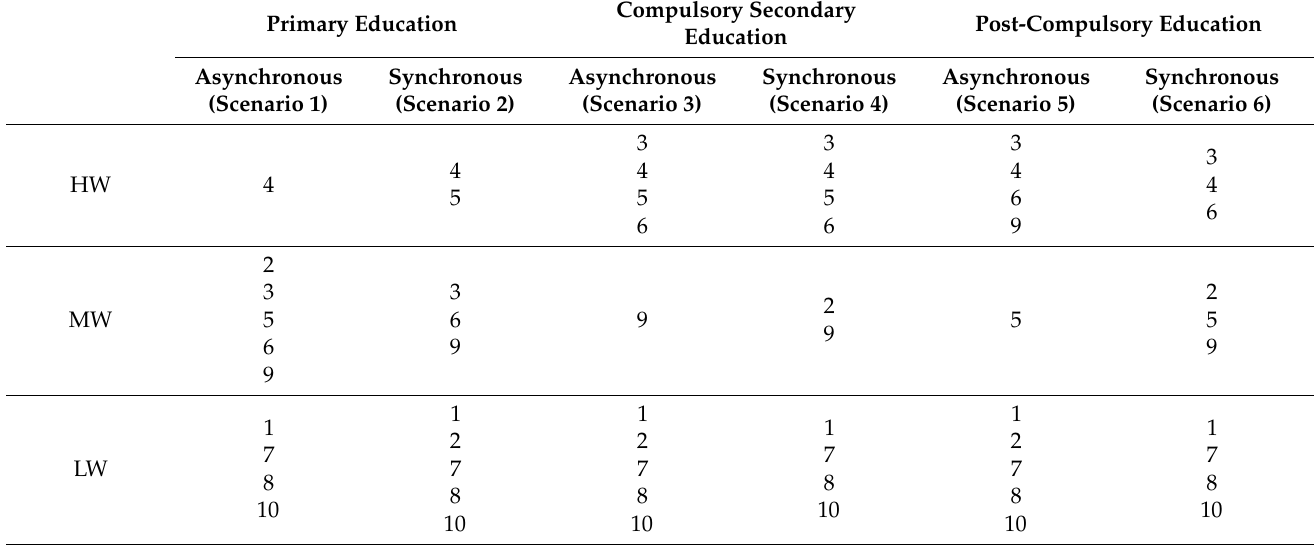
Table 8. Distribution of indicators according to weights in the study